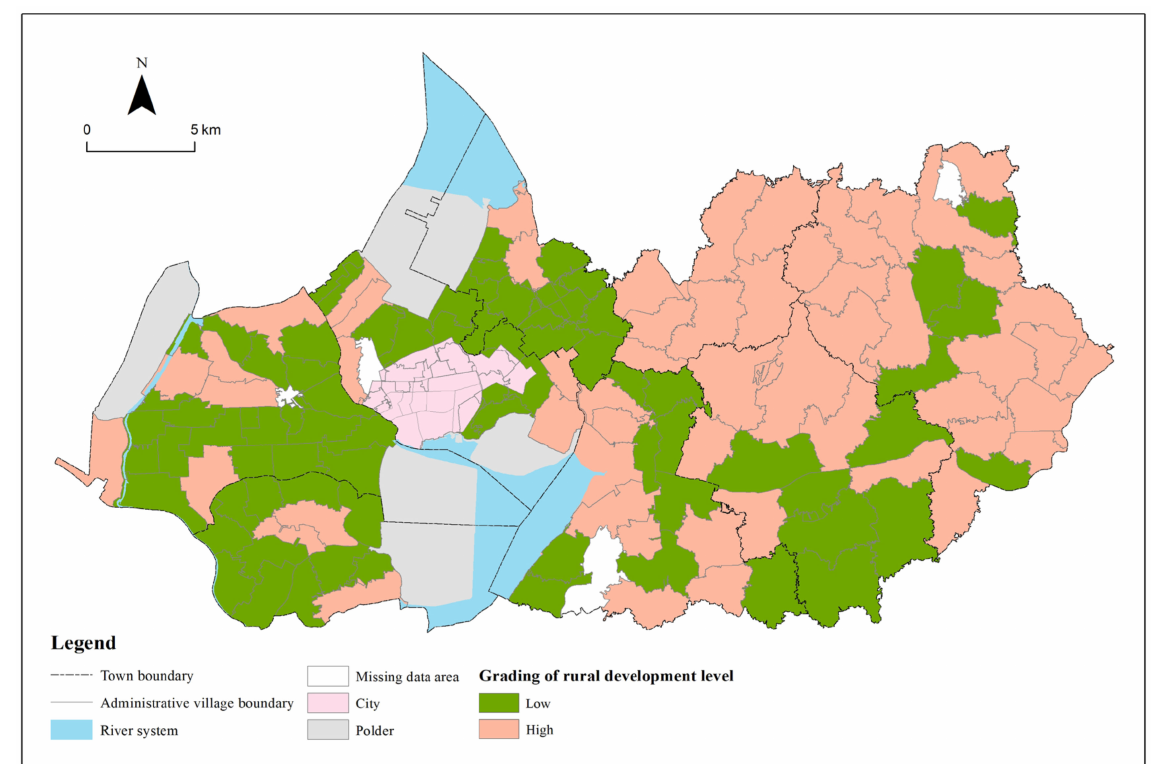
Figure 5. Development level distribution of administrative villages in Gaochun